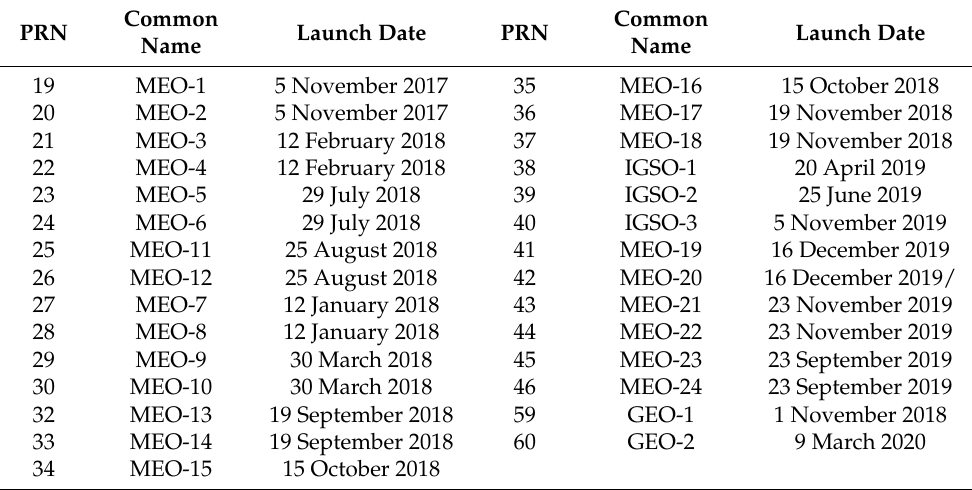
Table 2. Status of healthy BDS3 satellites (as of June